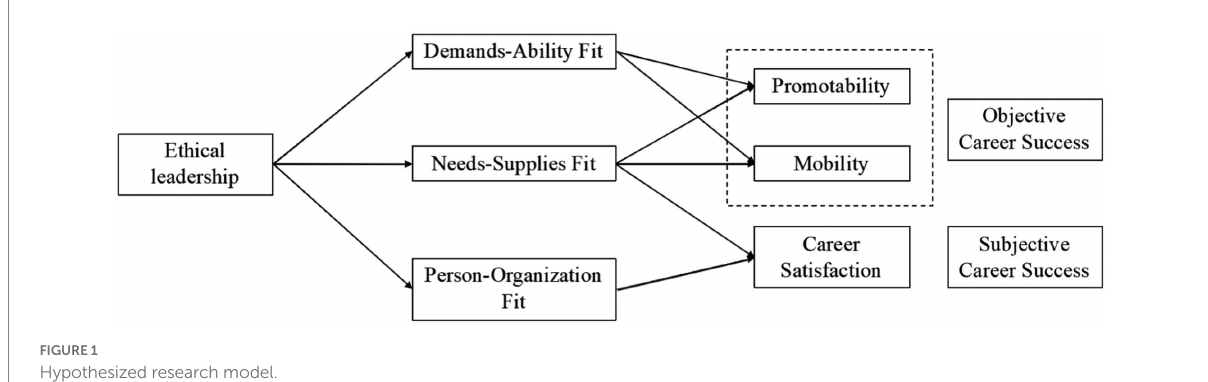
FIGURE 1 Hypothesized research